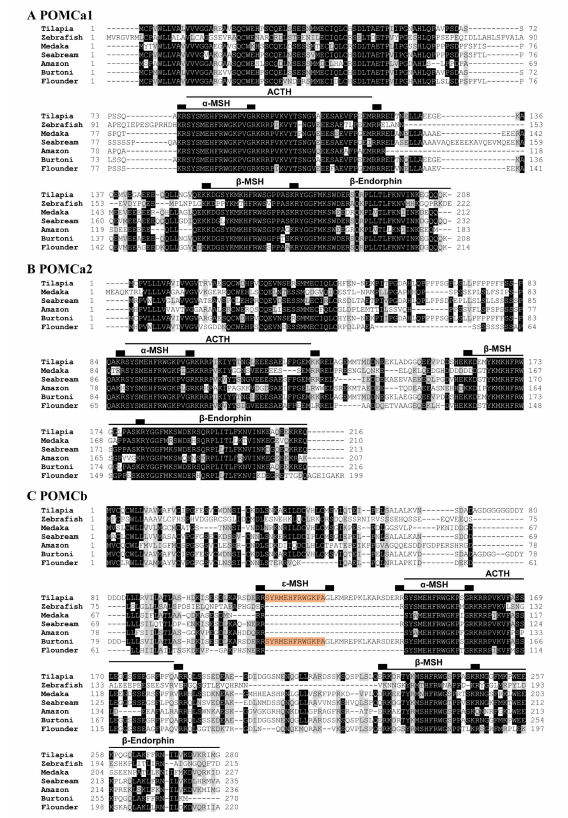
Figure 3. Alignment of POMC amino acid sequences in teleosts. ( A ) Amino acid alignment of the cloned tilapia POMCa1 (MT740811) with that of zebrafish (NP_852103), Japanese medaka (XP_004066504), gilthead seabream (AEI28997), amazon molly (XP_016536498), Burton’s mouthbrooder (NP_001273262), and barfin flounder (BAB18468). ( B ) Amino acid alignment of predicted tilapia POMCa2 (XP_003458632) with that of Japanese medaka (XP_023815525), gilthead seabream (AEI28996), amazon molly (XP_007569132), Burton’s mouthbrooder (NP_001302480), and barfin flounder (BAB18467). ( C ) Amino acid alignment of the cloned tilapia POMCb (MT740812) with that of zebrafish (NP_001076520), Japanese medaka (XP_004066504), gilthead seabream (AEI28997), amazon molly (XP_007552912), Burton’s mouthbrooder (NP_001273211), and barfin flounder (BAB18469). Horizontal lines indicate α -MSH / ACTH / β -MSH / β -endorphin peptides. The E -MSH in tilapia and Burton’s mouthbrooder are masked in orange. Black boxes indicate endoproteolytic cleavage